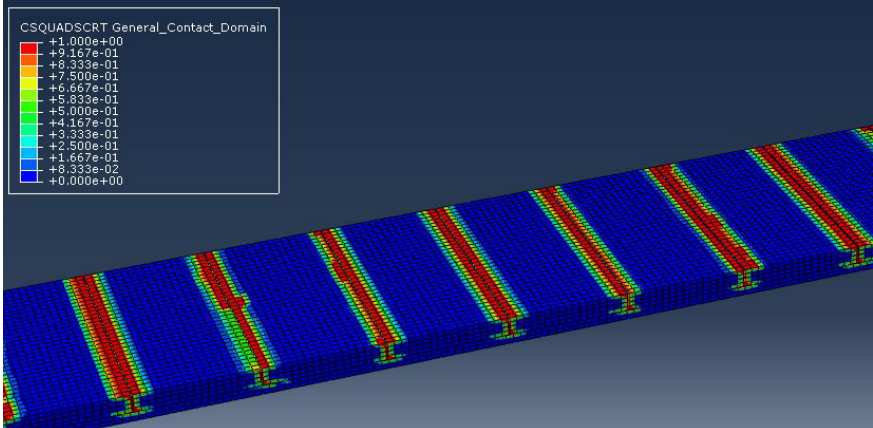
Figure 5. Modeling of the possible transverse cracks with cohesive interface. The existence of the shear lag zone is apparent. The upper layer is hidden to get a more clear image of the cracks and the delamination area. Values of CSQUADSCRT quantity are given in the